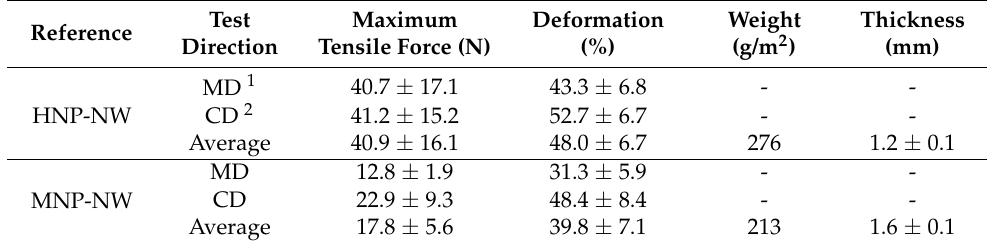
Table 2. Breaking force and deformation obtained from the tensile tests and weight and thickness of the high needle-punched (HNP-NW) and medium needle-punched (MNP-NW) nonwoven fabrics prepared as reinforcement for the cement